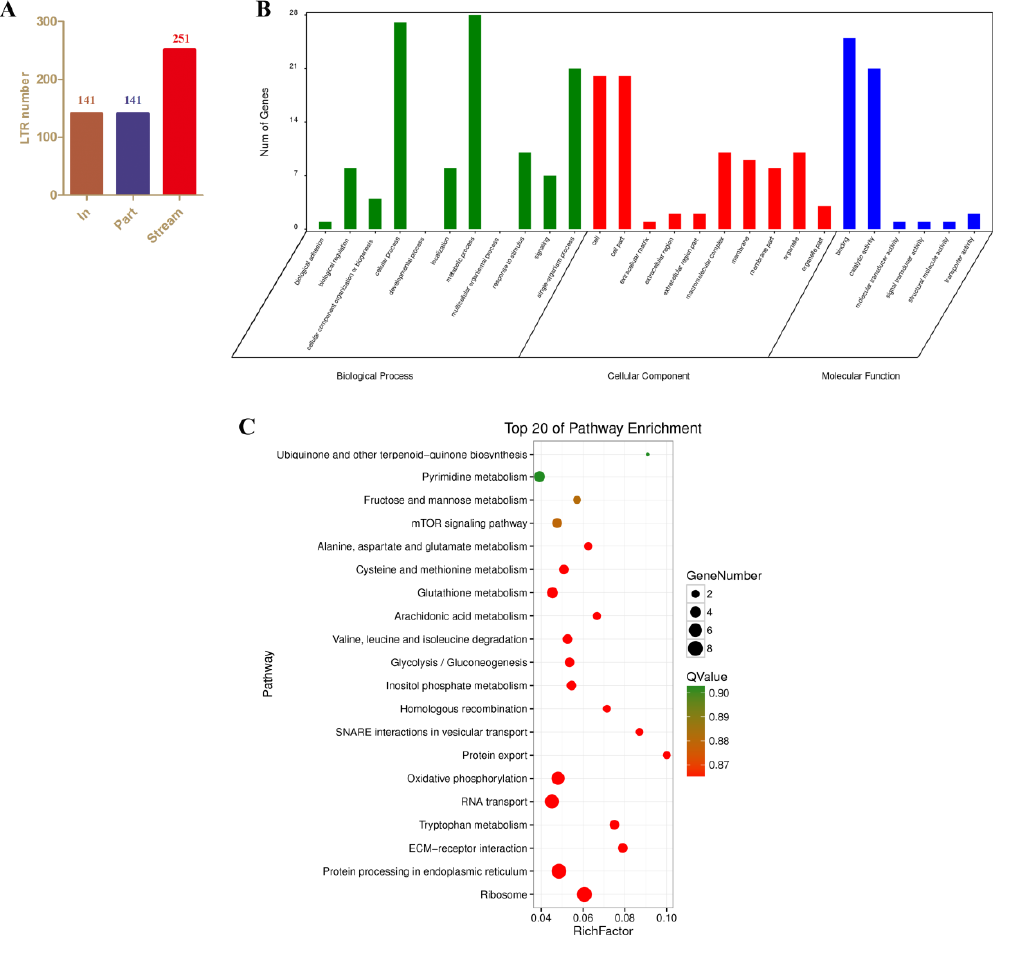
Figure 3. GO and KEGG analysis of the neighboring genes of independent full-length AyLTRs (“Stream”). ( A ) According to the positional relationship between AyLTRs and their neighboring genes, AyLTRs were classified into three types, “In”, “Part” and “Stream”. “In” represent AyLTRs that encompass gene exon sequences. “Part” represents AyLTRs that partially overlap with exon sequences. “Stream” represents independent AyLTRs that do not overlap with host gene exons. ( B ) Histogram description of Gene Ontology enrichment of neighboring genes of “Stream” AyLTRs. Genes were assigned to three categories: biological process (BP), cellular component (CC), and molecular function (MF). (C) The neighboring genes of “Stream” AyLTRs that were enriched in KEGG pathways. Genes located ∼ 100 kb upstream and downstream of “Stream” AyLTR were identified as “neighboring” genes.